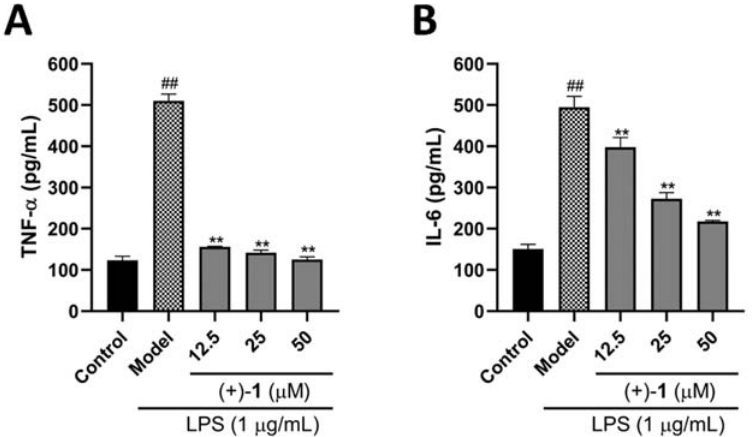
Figure 6. Effects of compound (+) ‐ 1 on inflammation ‐ related cytokines on RAW 264.7 cells. ( A ) Com ‐ pound (+) ‐ 1 decreased TNF ‐α expression levels. ( B ) Compound (+) ‐ 1 decreased IL ‐ 6 expression lev ‐ els. Values are presented as mean ± SEM of three independent experiments. ## p < 0.01 vs. control group, ** p < 0.01 vs. model group.